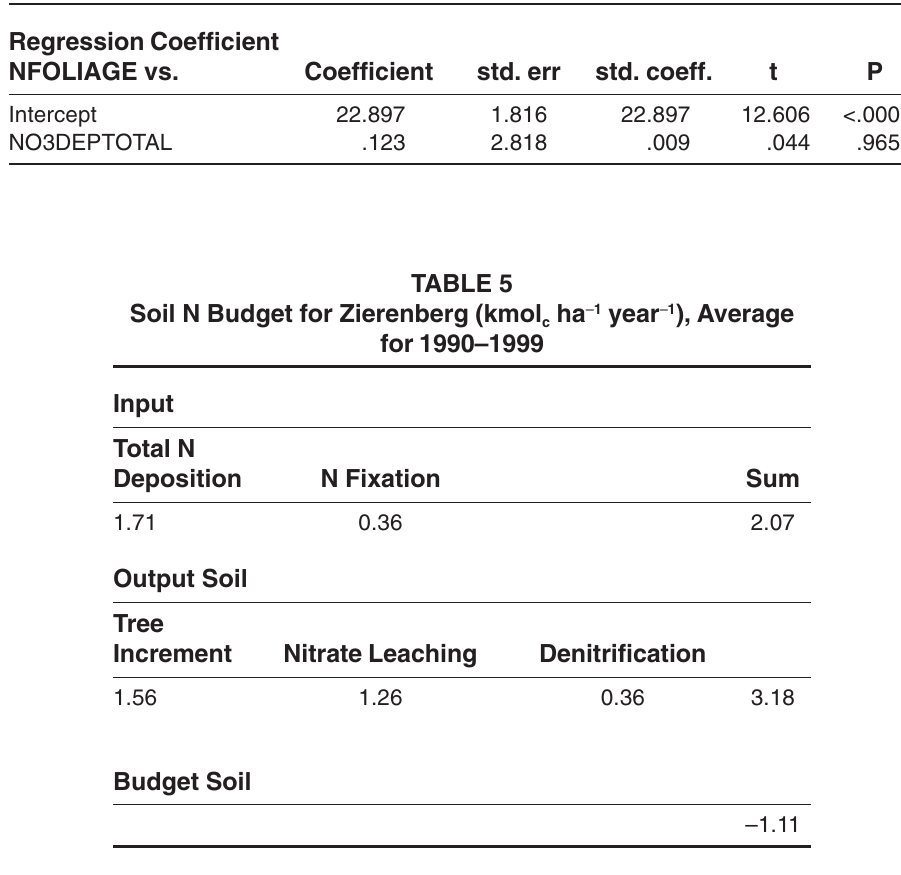
N Content Foliage (F. sylvatica; Vegetation Period Sampling) vs. NO